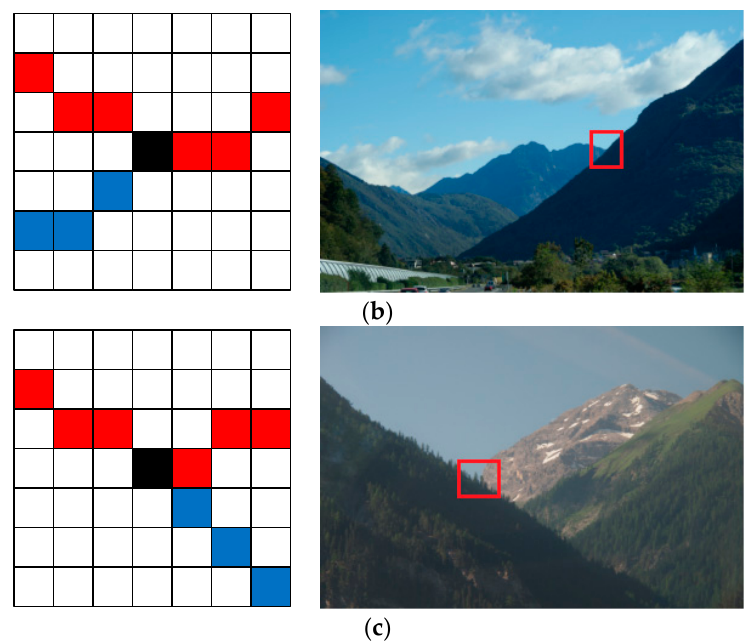
Figure 15. The lapel point of skyline: Row ( a ) Normal point of skyline; Row ( b ) Left lapel point of skyline; and Row ( c ) Right lapel point of skyline. The black dots are the skyline points to be detected. The red dots are the skyline points and the blue points are the ridge line points.